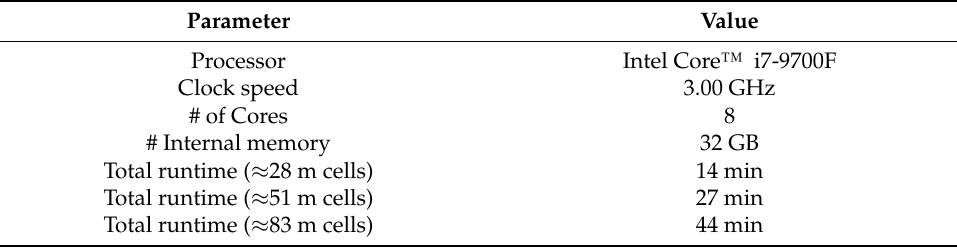
Table 6. Pointwise mesh generation system specifics and runtime.